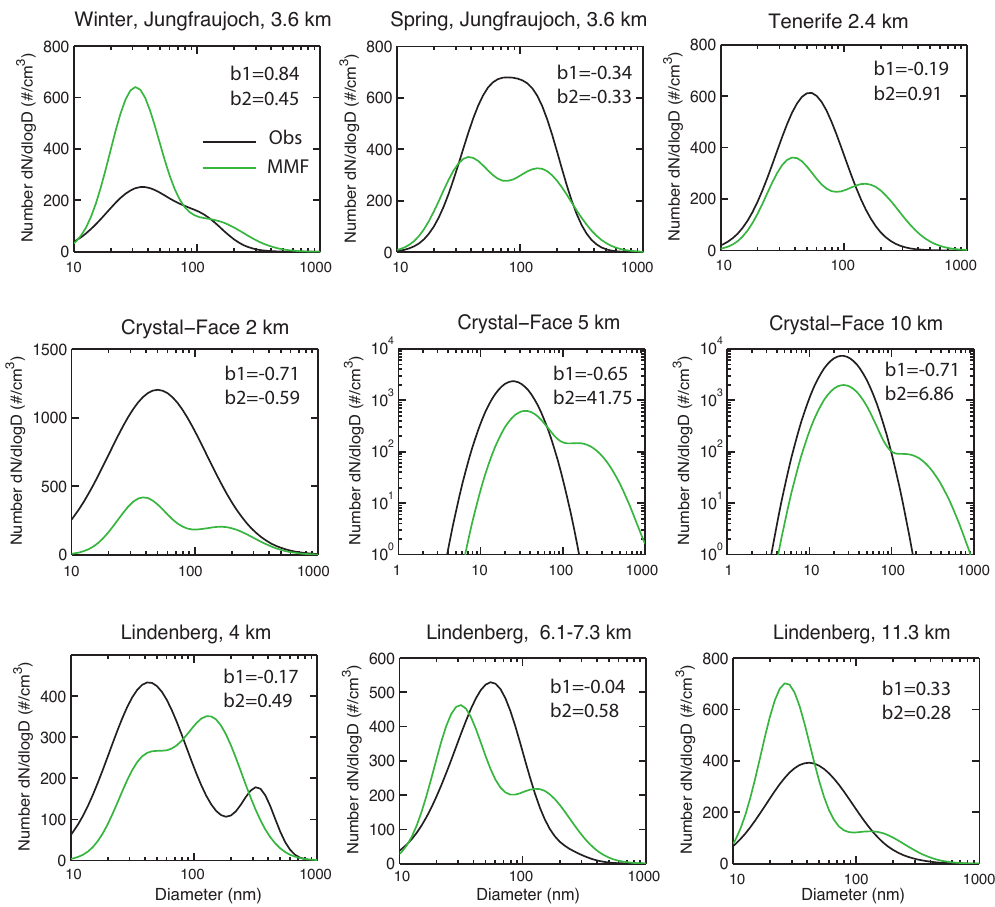
Fig. 19. Aerosol size distributions in the free troposphere. Observations (Obs) are from Putaud et al. (2003) (Jungfraujoch), Raes et al. (2000) (Tenerife); Fridland et al. (2004) (CRYSTAL-FACE, Florida, United States); and Petzold et al. (2002) (LACE8, Lindenberg, Germany). Normalized model bias for the aerosol number concentrations with diameter larger than 10nm (“b1”) and diameter larger than 100nm (“b2”) are shown in each